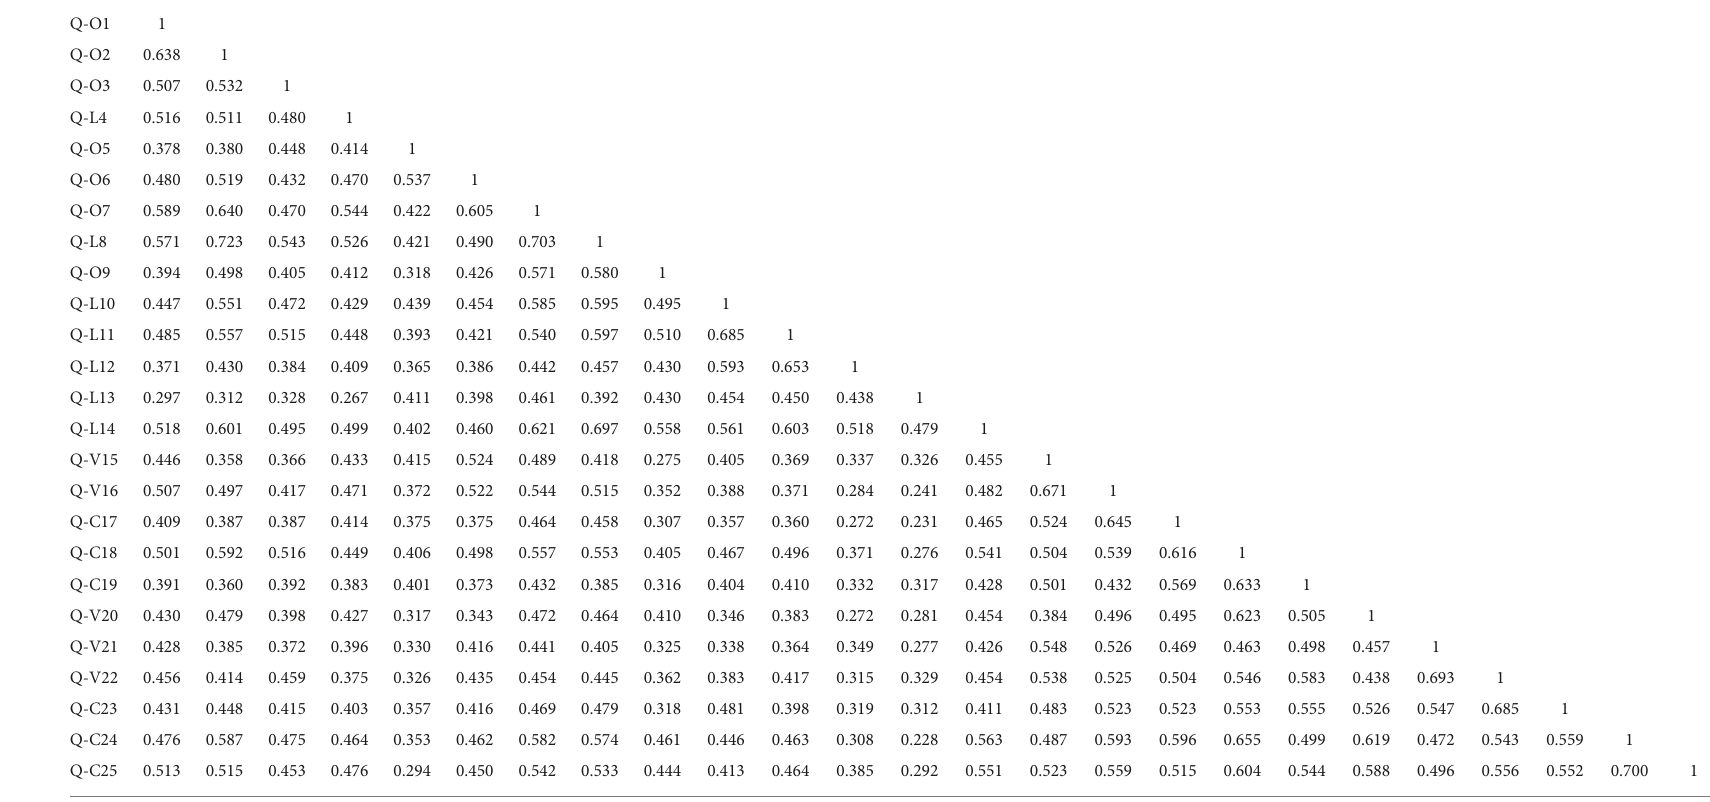
TABLE 5 Correlation matrix of USR’s